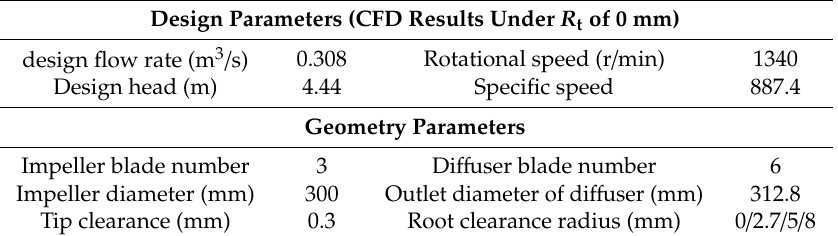
Figure 1. 3D model of the axial flow pump device. Table 1. Main parameters of the axial flow pump device.